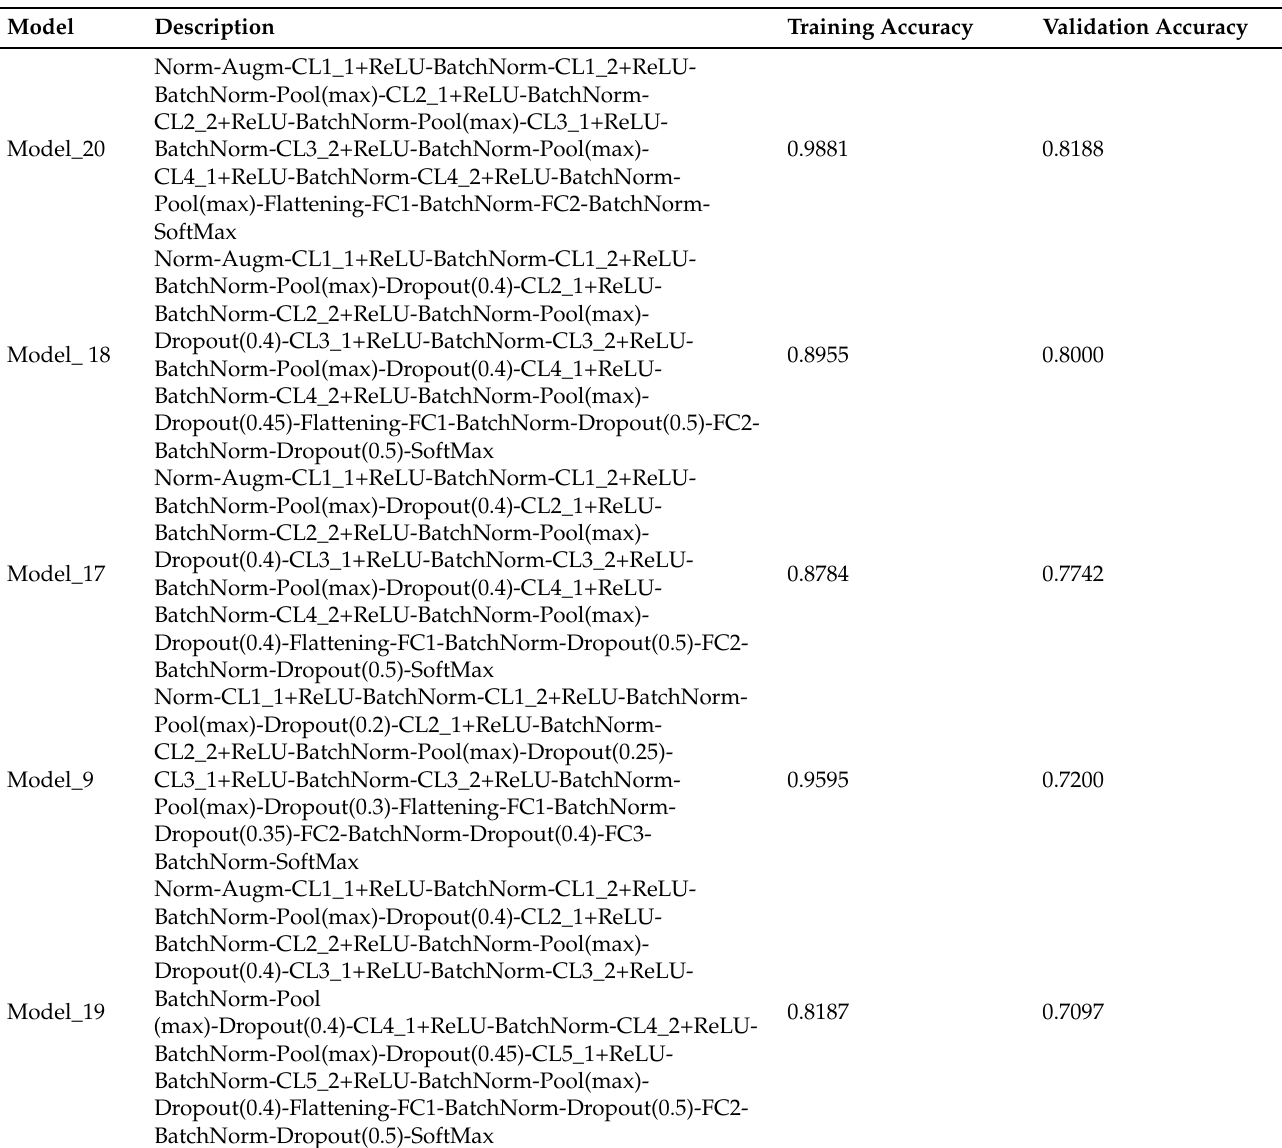
Table 2. CNN models with 5 best validation